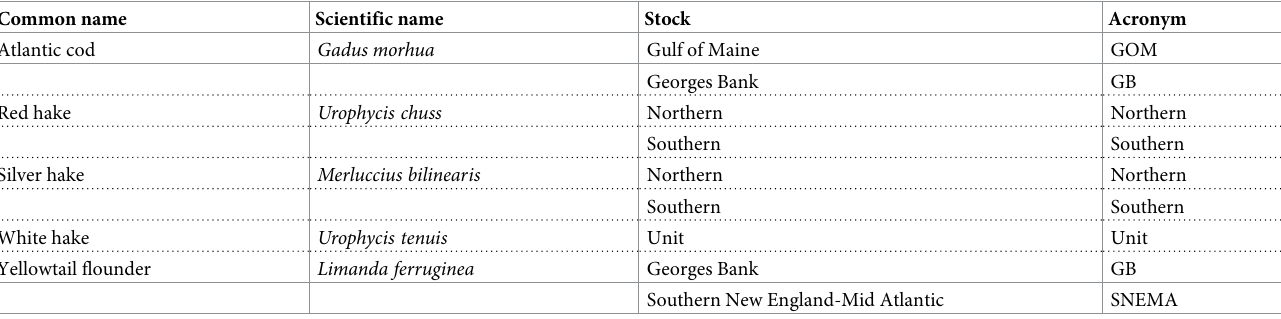
Fig 1. Northeast Fisheries Science Center bottom trawl survey offshore strata. Stock strata definitions are shown for Gulf of Maine and Georges Bank cod (upper left), the northern and southern stocks of red hake and silver hake (upper right), Georges Bank and (spring only) Southern New England-Mid Atlantic yellowtail flounder (lower left). Ecoregions used in previous analyses are also shown (lower right). Further details, as well as the stock strata definition for white hake, are provided in S1 Supporting Information. https://doi.org/10.1371/journal.pone.0196583.g001 were applied as necessary. The stocks considered in this analysis are listed in Table 1. Bottom temperature data are collected at all NEFSC trawl stations [21]. Catch data (landings + dis- cards) through 2016 were taken from the most recent assessment update for each stock (links Table 1. Northwest Atlantic groundfish stocks analyzed in the present